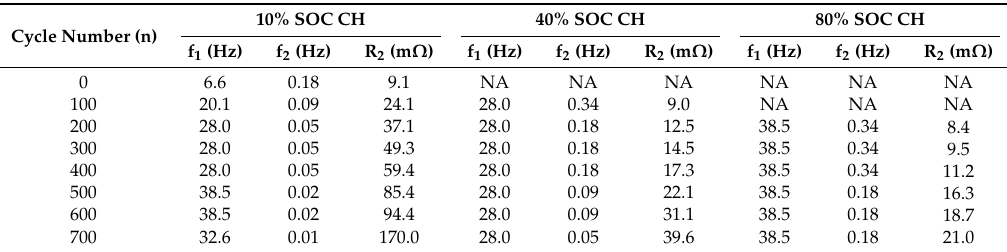
Table 2. Quantitative parameters derived from the AC impedance spectroscopy of the LCO + NMC532/Gr full cells at various SOC (state of charge) during charging.